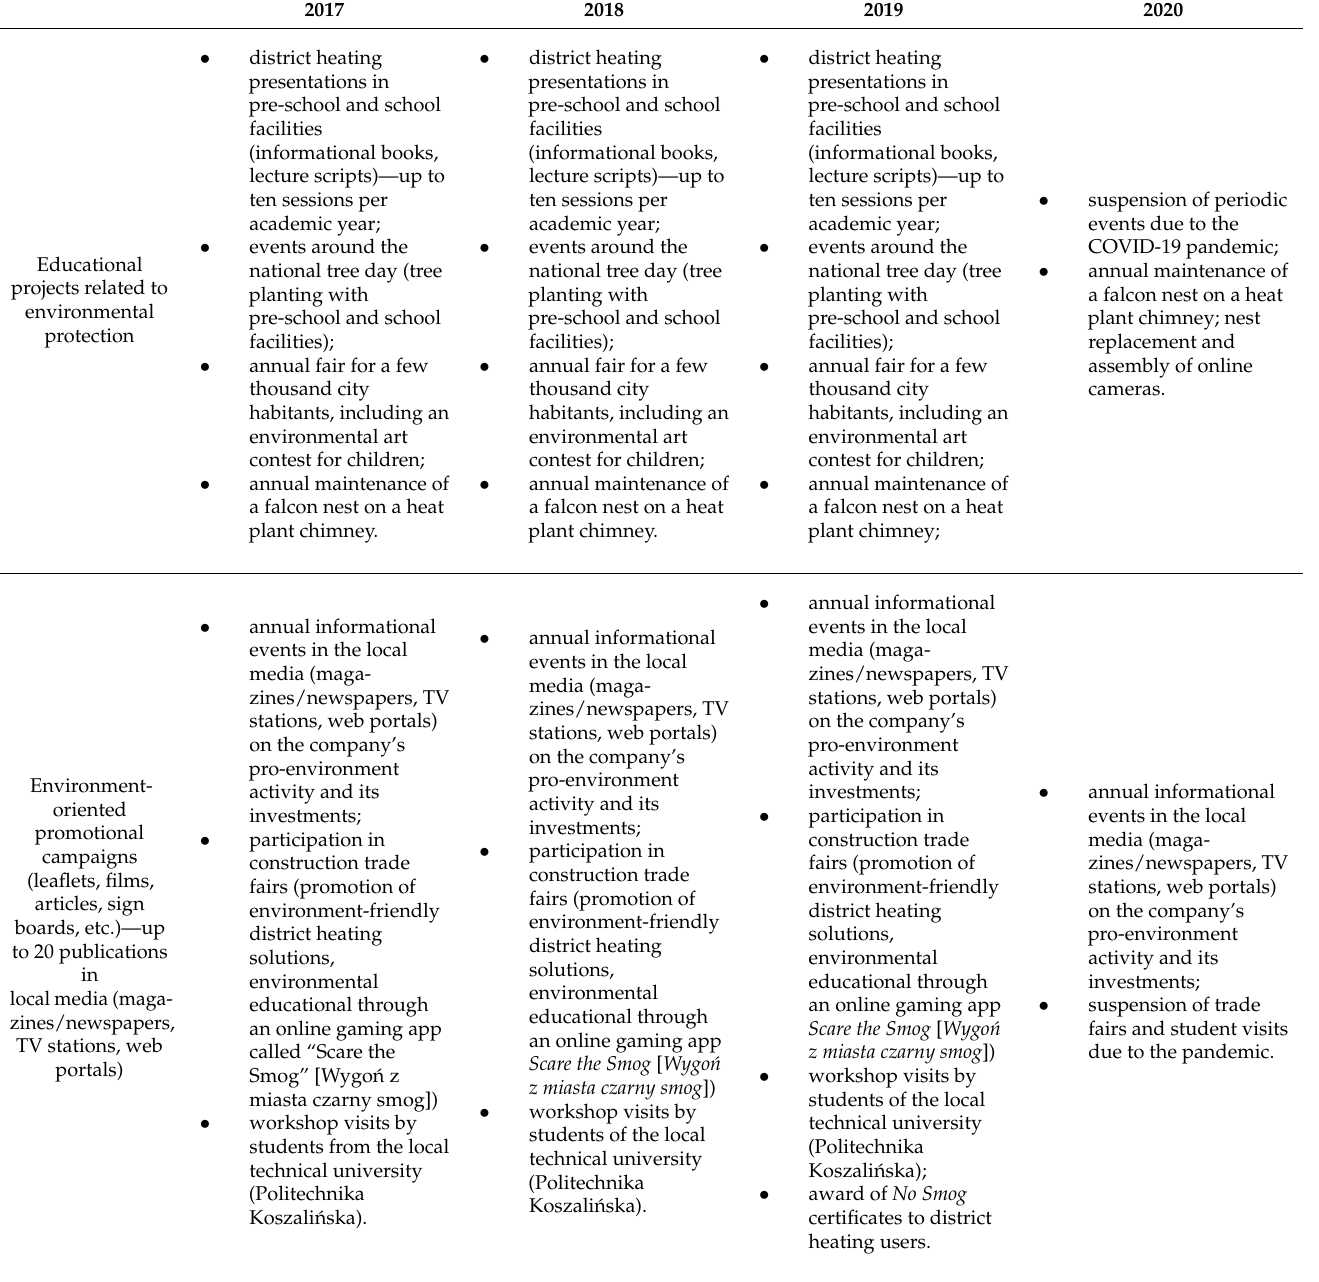
Table 2. List of Environmental Corporate Social Responsibility (ECSR) educational projects of Miejska Energetyka